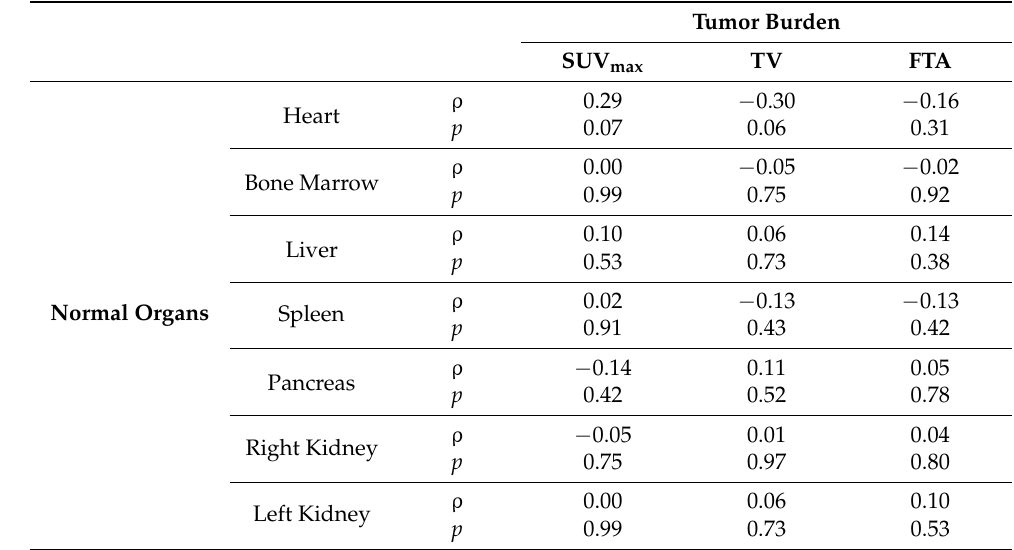
Table 3. Correlation (Spearman’s Rho, ρ ) to determine associations between radiotracer uptake in normal organs and tumor lesions.